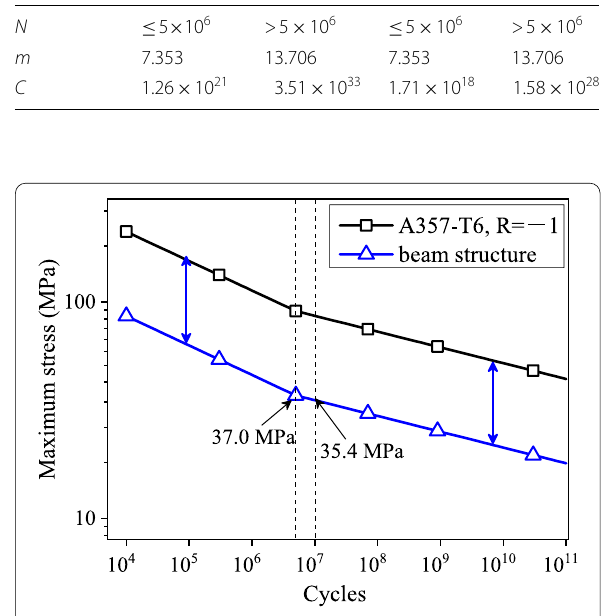
Figure 13 Comparison of structural and material S–N curves, as obtained from modification with fatigue strength reduction